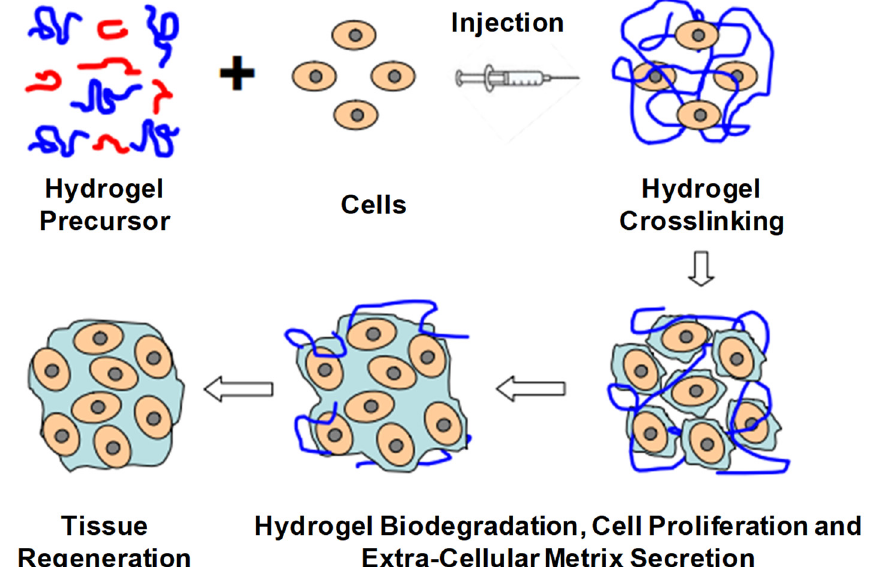
Figure 16. Schematic illustration of biodegradable injectable hydrogel for tissue regeneration approaches. Cells are isolated from a small biopsy, expanded in vitro and encapsulated in hydrogel precursors, which are subsequently transplanted into the patient by injection using a needle. Hydrogels provide initial structural support and retain cells in the defective area for cell growth, metabolism and new extracellular matrix (ECM) synthesis. The hydrogel is readily degradable when the cells secrete ECM. This strategy enables the clinician to transplant the cell, growth factor and hydrogel combination in a minimally invasive manner. Adapted with permission from ref. [6]. Copyright © 2010 Material by MDPI.